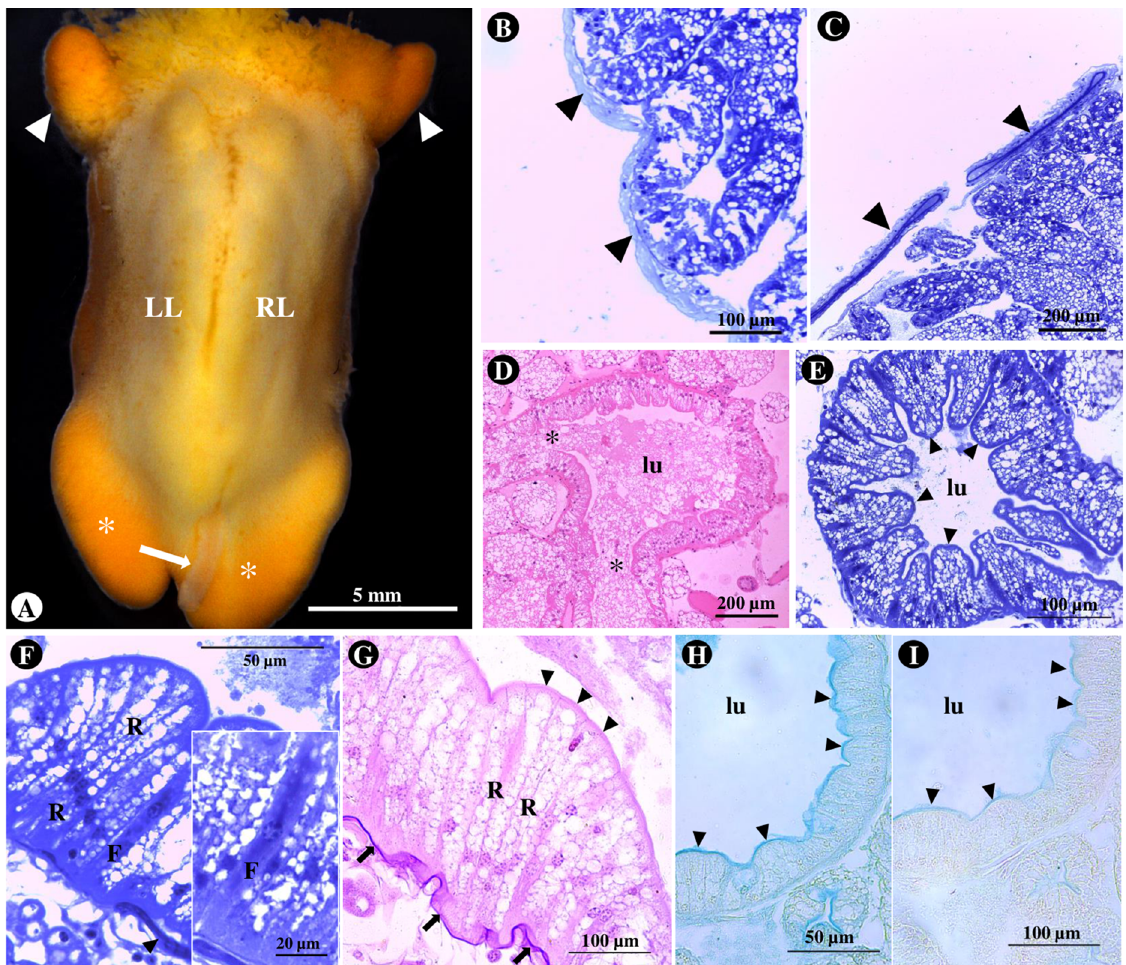
Figure 1. Hepatopancreas of Macrobrachium carcinus . ( A ) Dorsal anatomical view of the hepatopancreas showing the right lobe (RL) and the left lobe (LL) with anterior prominences (arrowhead) and posterior ones (asterisks). Note part of intestine arising from lobes (arrow). ( B, C ) Histological section of the hepatopancreas exhibiting in the periphery a connective tissue capsule (in B - arrowhead) and extra-hepatopancreatic vessels (in C - arrowhead). ( D ) Primary duct branching into hepatopancreatic ducts (asterisks). ( E ) Transverse section of a hepatopancreatic duct showing epithelial projections (arrowheads) towards the lumen. ( F ) Detail of ductal epithelium showing elongated R- and F-cells; Inset: detail of basophilic F-cell in the hepatopancreatic duct. ( G–I ) Histochemistry of hepatopancreatic ducts, highlighting the brush border region of epithelial cells (arrowheads) and basement membrane region (in G - arrows). Abbreviations: F: F-cells; lu: lumen; R: R-cells. Staining and Reactions: toluidine blue ( B, C, E,